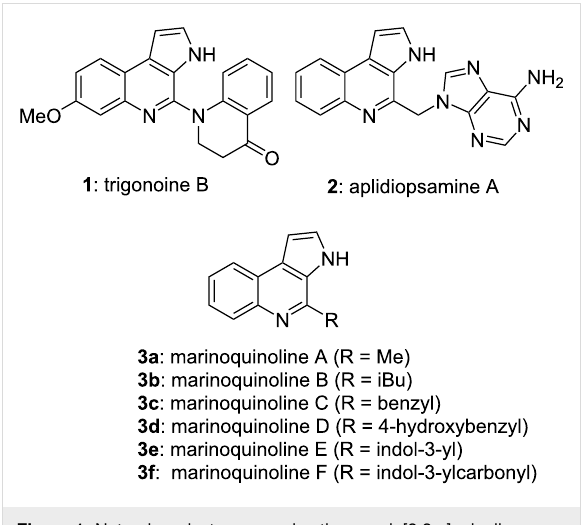
Figure 1: Natural products possessing the pyrrolo[2,3- c ]quinoline skeleton.